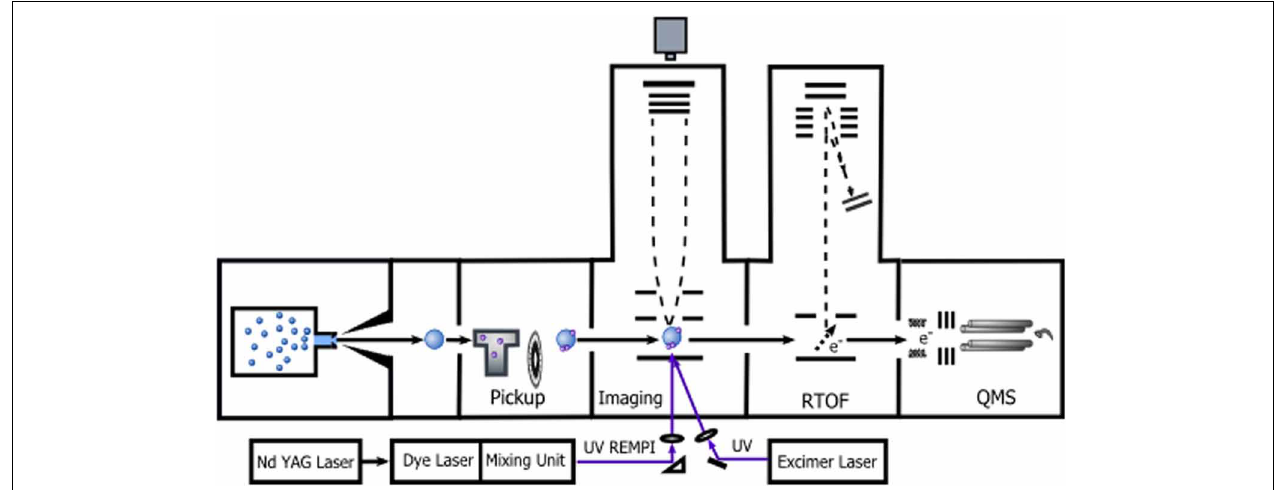
FIGURE 1 | Schematics of the experimental apparatus CLUB and the experiments outlined in this